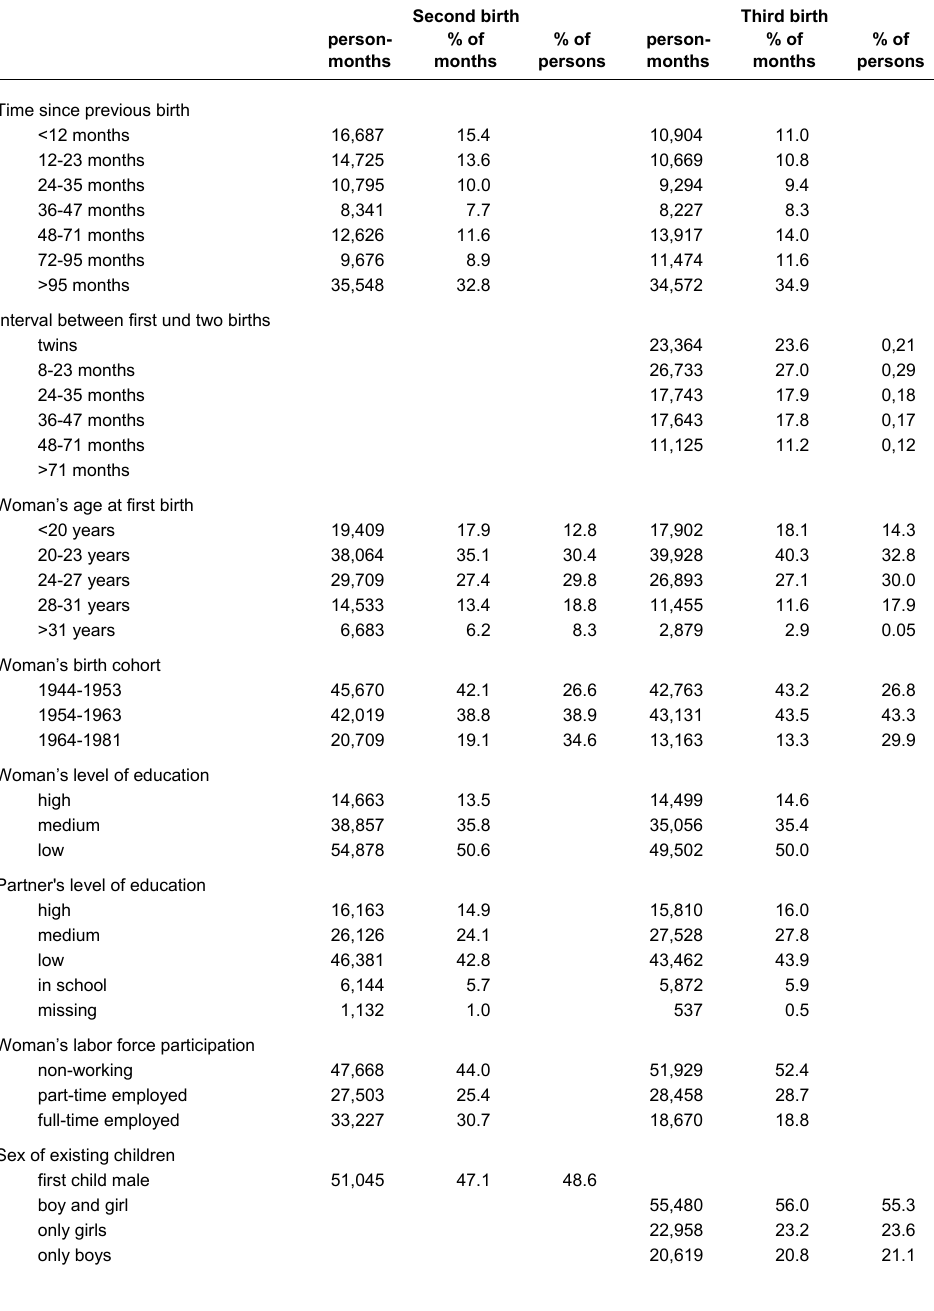
Table 1 : Distribution of the independent variables